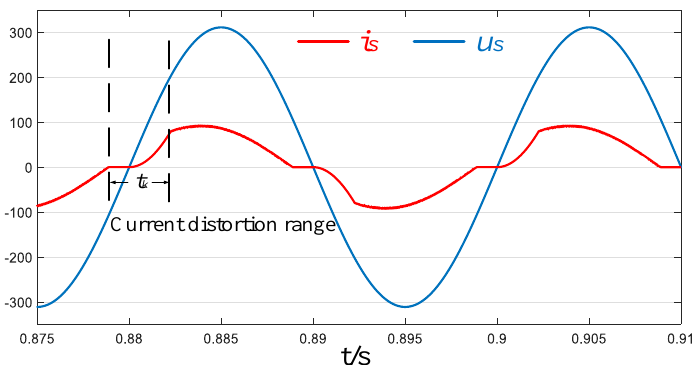
Figure 16. Theoretical and simulation THD under a unity power factor.